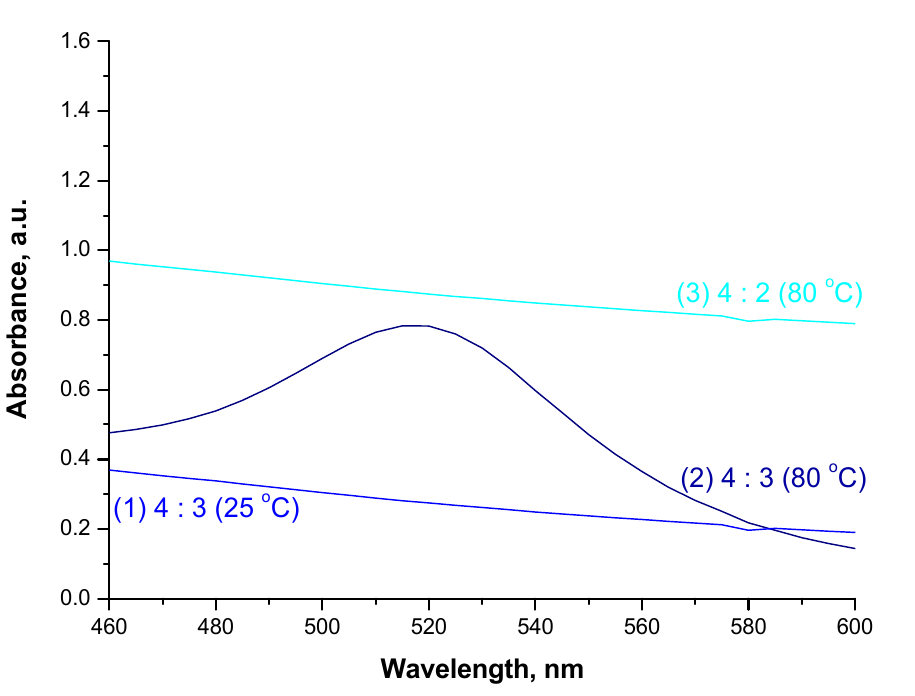
Figure 10. UV-Vis spectra of suspensions obtained under various Fe 3 O 4 @Au nanoparticle synthesis